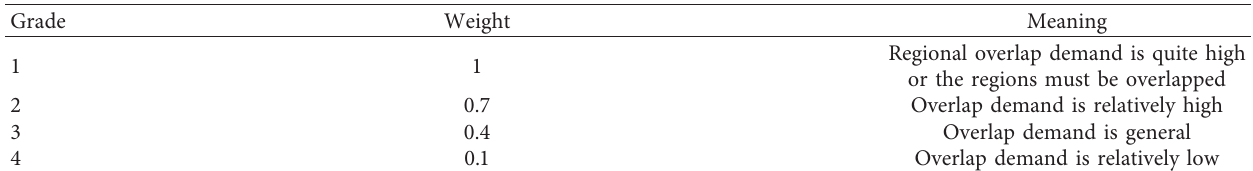
Table 3: Overlapping weight grade and definition of